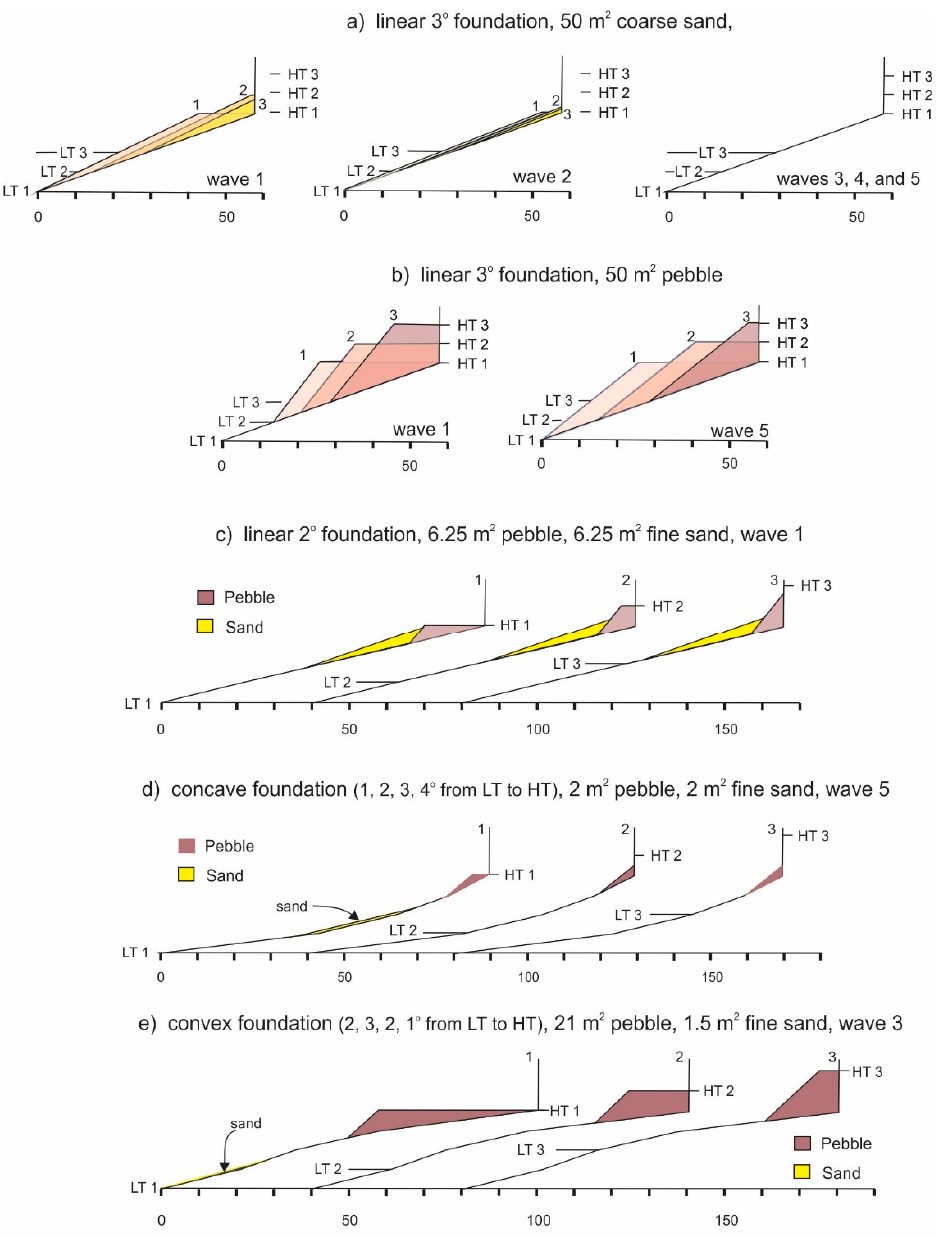
Figure 7. Examples of simulated platform beach responses to rising sea level and their relationship to the shape and gradient of the rock foundation, the amount and grain size of the sediment, and the height of the waves (wave 1 to 5 represents increasing height). LT (1, 2, and 3) and HT (1, 2, and 3) represent, respectively, the mean low water spring and mean high water spring tidal levels for present sea level and two higher sea levels equal to 1/4 and 1/2 of the tidal range above today [40]. 5.